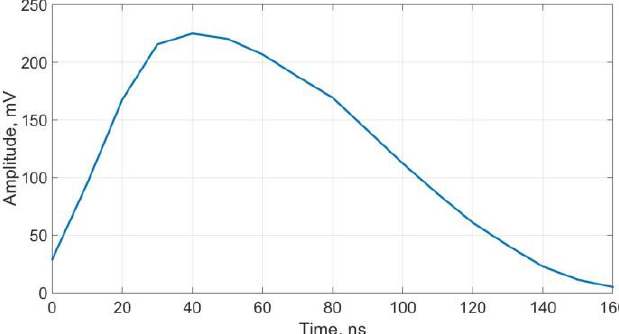
Fig. 3. Normalized averaged pulse shape of the high sensitivity FC with a 235U to set into the FC signal simulator.